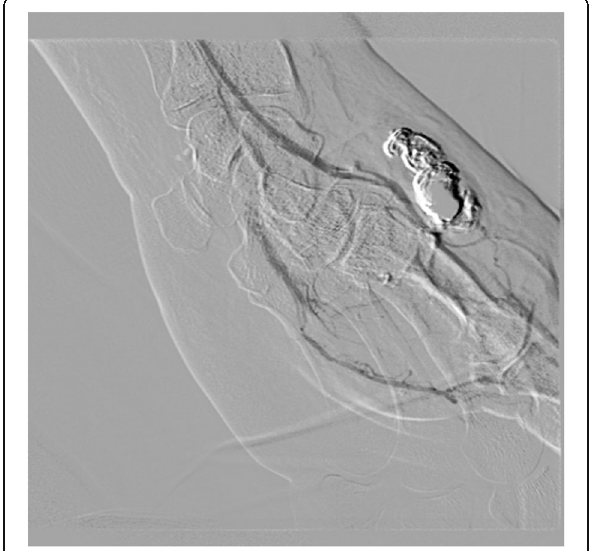
Fig. 2 Post intervention angiogram showing exclusion of the pseudoaneurysm and preservation of the left palmar arch